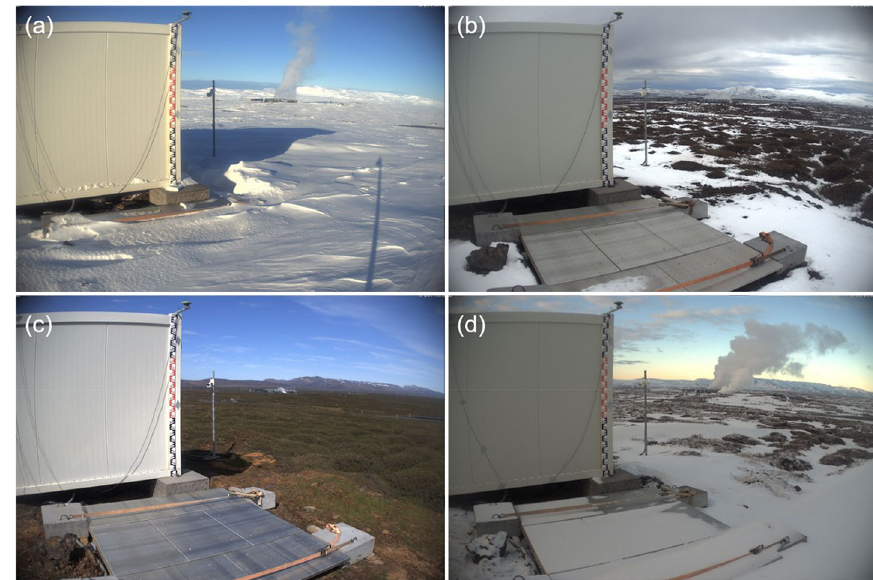
Fig. 16 East station (SCGE) in the course of the four seasons in 2019: a February, b May, c August and d November